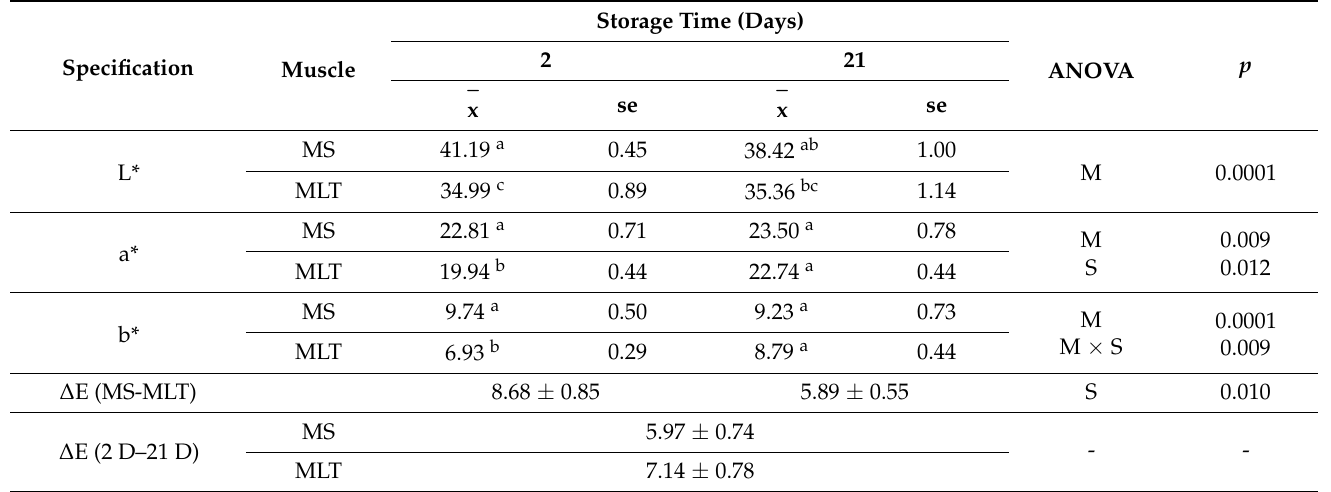
Table 2. Color parameters of raw beef depending on the type of muscle and cold storage